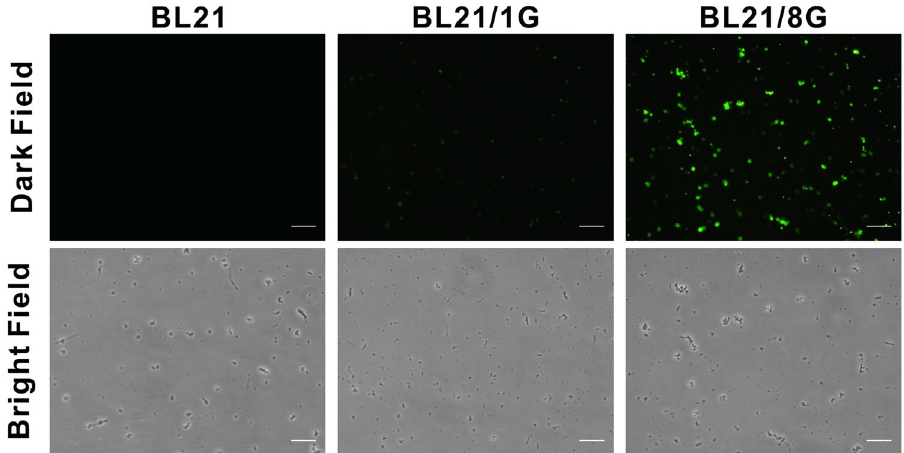
Figure 3. Fluorescent microscopy of poly-protein G-expressing bacteria labeled with FITC-conjugated antibody. The antibody-trapping ability of BL21, BL21/1G and BL21/8G was analyzed by FITC-conjugated goat antibody under a fluorescent microscope. Top panels, green fluorescence of FITC under dark field. Bottom panels, images of bacteria under bright field. Bar = 10 μ